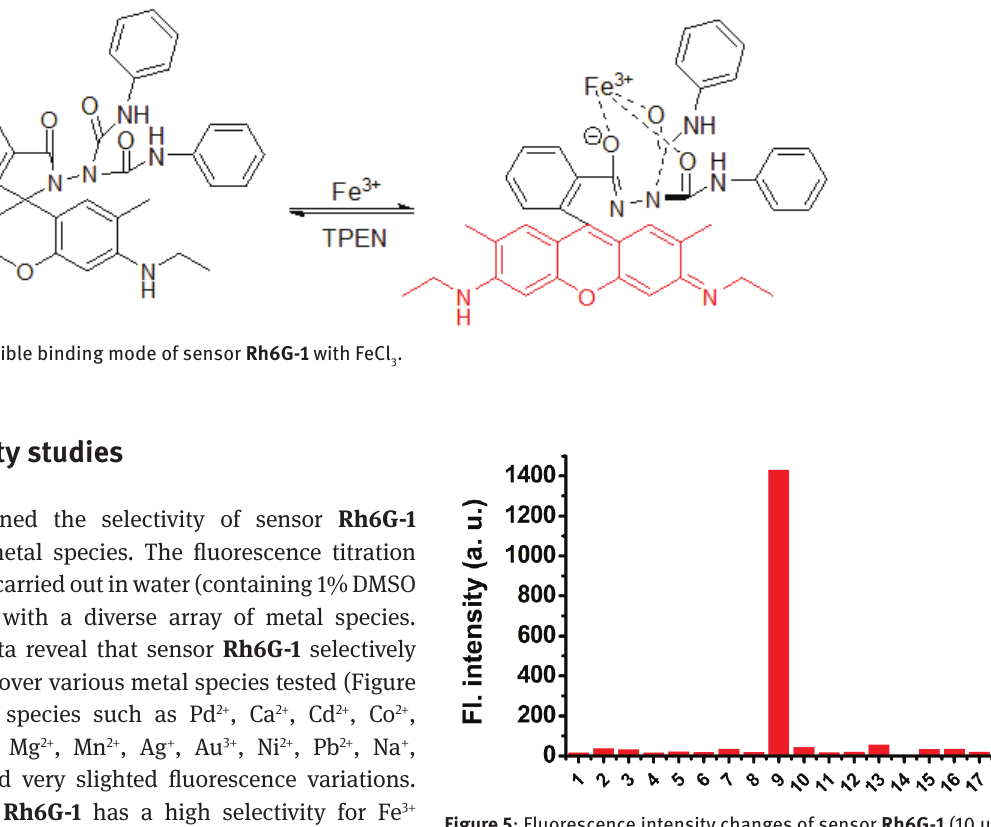
Figure 5 : Fluorescence intensity changes of sensor Rh6G-1 (10 μM) in response to various metal species (20 equiv.) in water (containing 1 % DMSO as a cosolvent). 1. none; 2. Pd 2+ ; 3. Ca 2+ ; 4. Cd 2+ ; 5. Co 2+ ; 6. Zn 2+ ; 7. Cu 2+ ; 8. Fe 2+ ; 9. Fe 3+ ; 10. Hg 2+ ; 11. Mg 2+ ; 12. Mn 2+ ; 13, Ag + , 14, Au 3+ , 15. Ni 2+ ; 16. Pb 2+ ; 17. Na + , 18. K + . Excitation at 500 nm; emission at 556 nm.